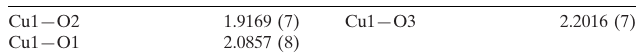
Selected bond lengths (A˚ ).